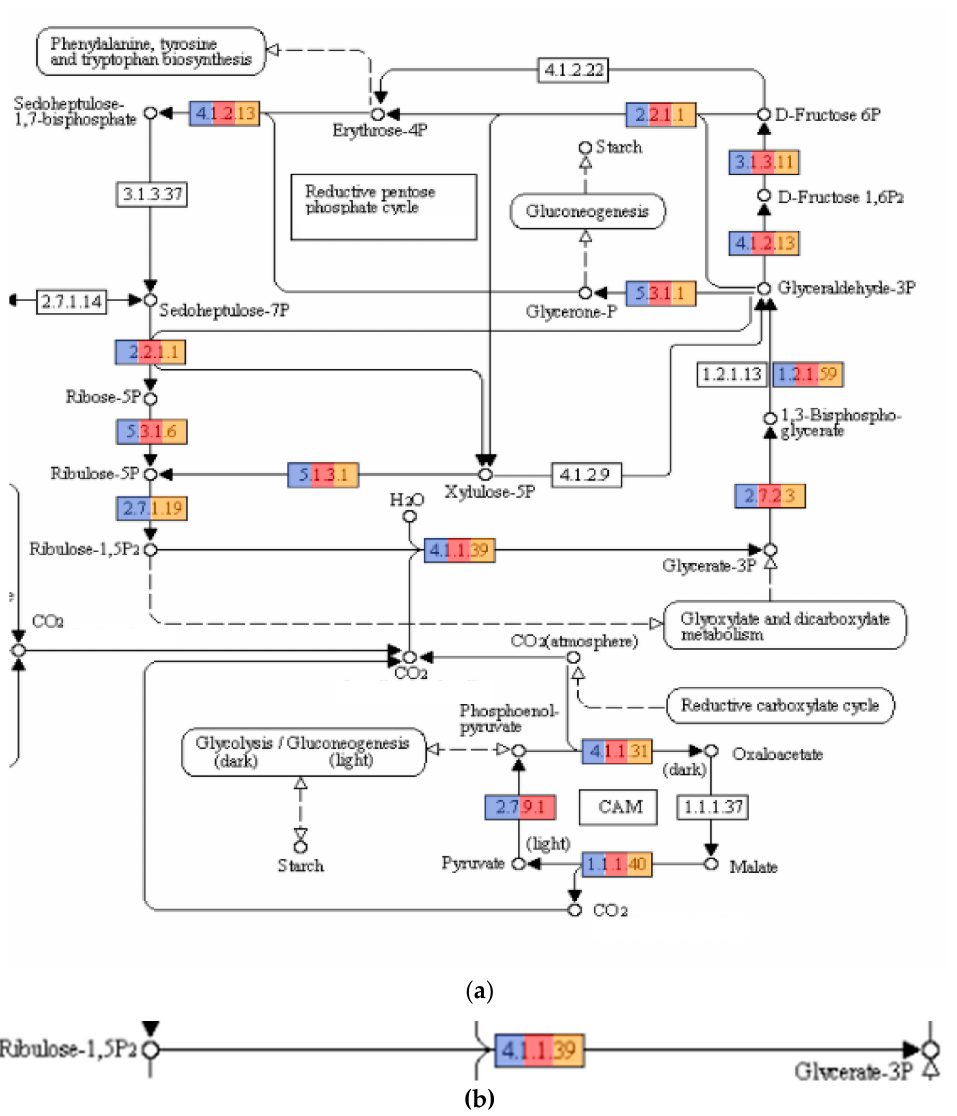
Figure 4. ( a ) Carbon metabolism pathways detected in the three metagenomes. Colored enzymes indicate the presence of the enzyme, light blue indicates presence in MFF1, red indicates presence in MFF2, and orange indicates presence in MFF3 (number of hits for each enzyme can be seen at Table S1 of supplementary figures). ( b ) Reaction catalyzed by the enzyme Ribulose-1,5-bisphosphate carboxylase/oxygenase (RuBisCO). The enzyme is present in all three metagenomes. Pathways obtained from KEGG pathways ( https://www.genome.jp/kegg/pathway.html ) with permission.